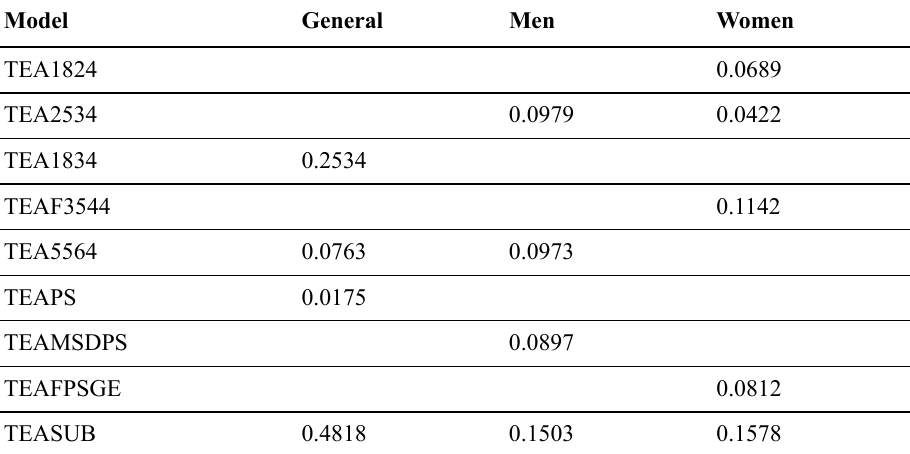
Table 4. Average variable